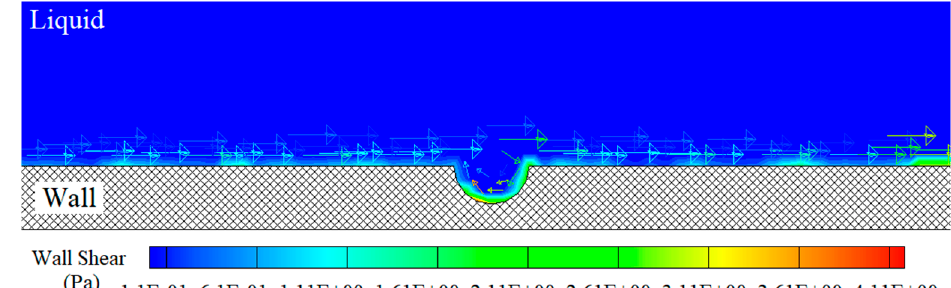
Figure 12. Flow field distribution in the corrosion pit.